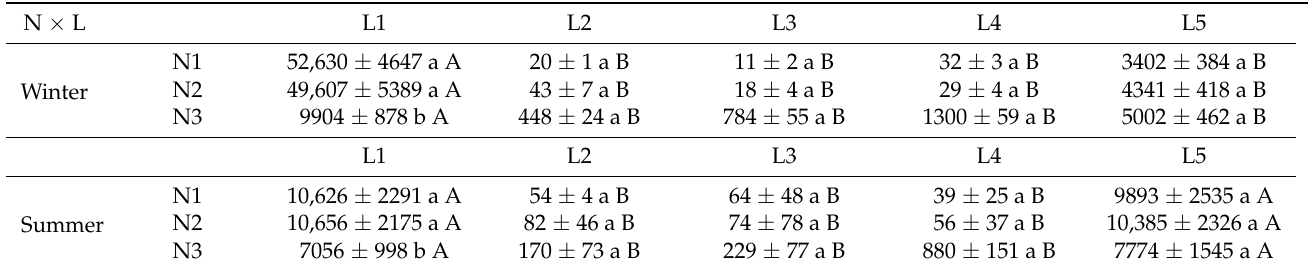
Table 3. Mean and standard deviation of light intensity (lux) obtained in the 43W aviary in winter and summer for the N × L interaction.